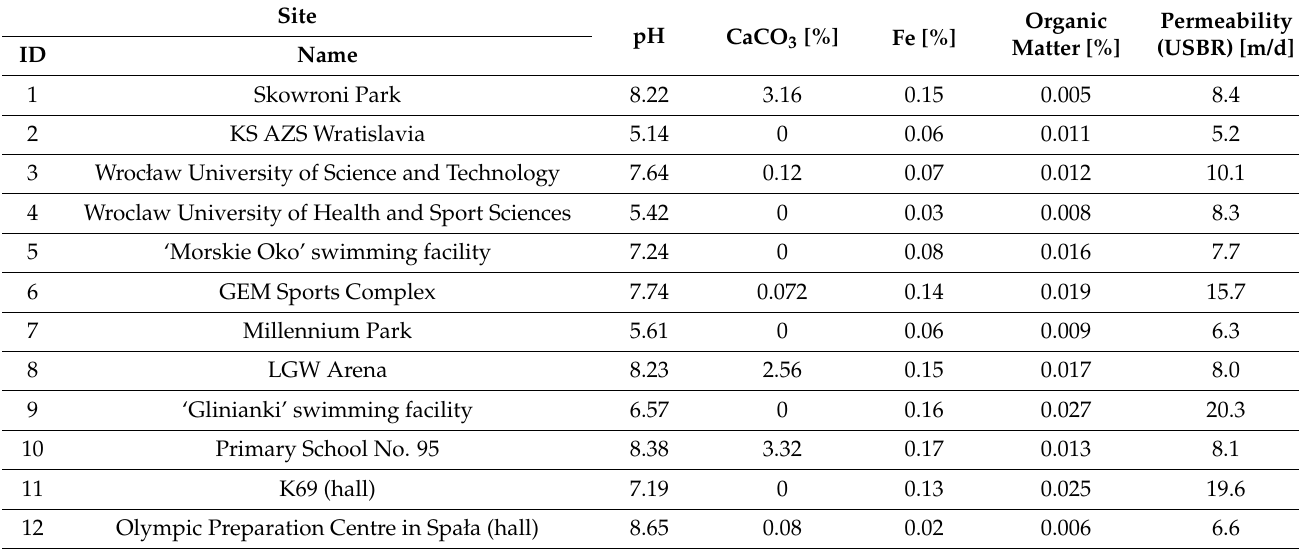
Table 5. Chemical properties and permeability of